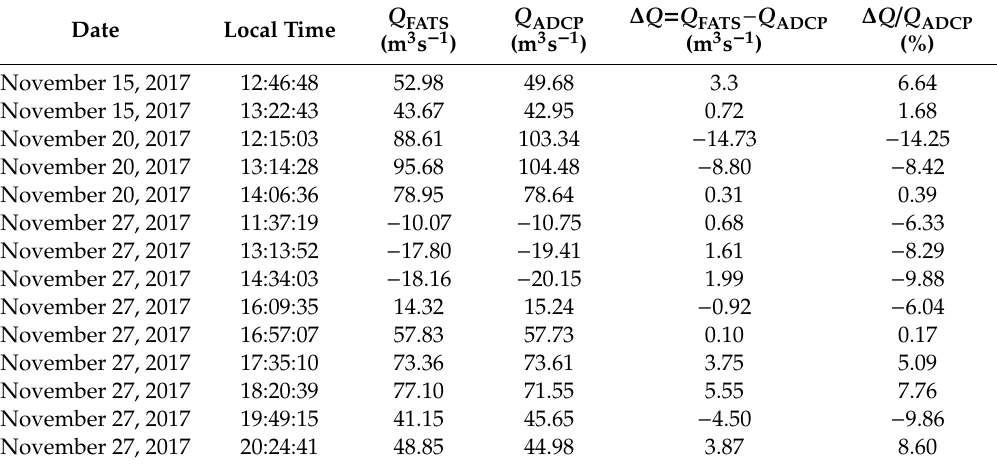
Table 5. Comparison between FATS and ADCP measurements at the northern